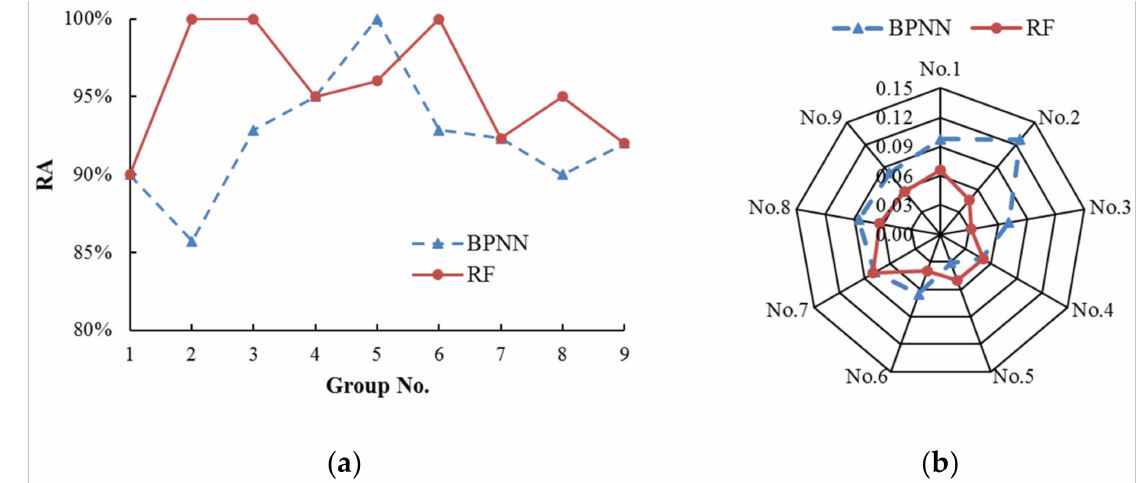
Figure 6. Index results of the No. 2 student in the first experiment: ( a ) RA; ( b ) MSE.